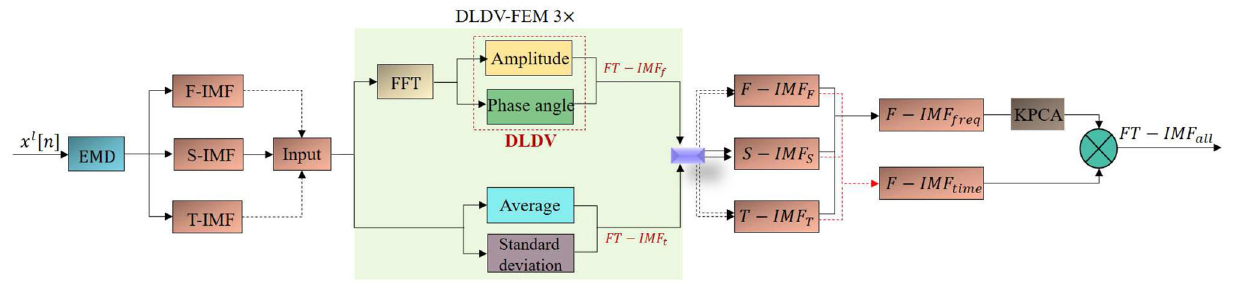
component of ECG through the amplitude value and phase angle, so it is called the depth local dual-view